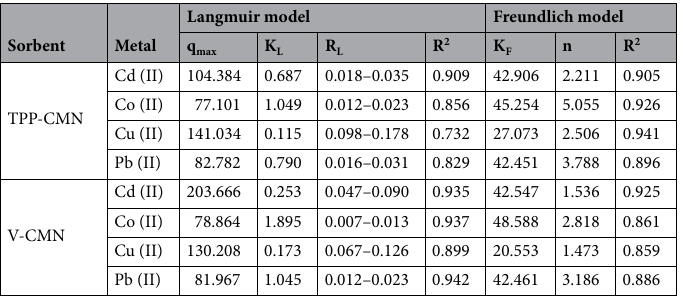
Table 2. Langmuir’s and Freundlich’s isotherm parameters for Cd (II), Co (II), Cu (II), and Pb (II) ions adsorption using TPP-CMN and V-CMN nano-sorbents.